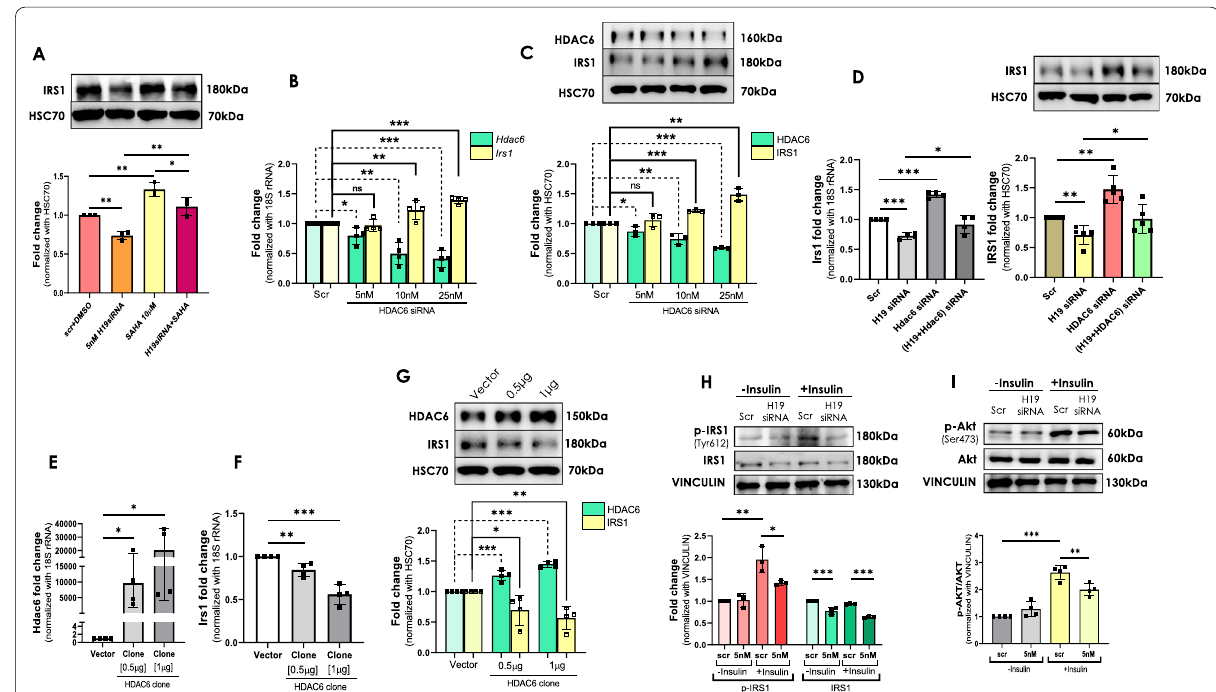
Fig. 5 H19 inhibition regulates IRS1 levels in HDAC6 dependent manner and impairs insulin signaling in C2C12 cells. A Differentiated C2C12 cells were transfected with the scramble or H19 siRNA (5 nM) and treated with wither DMSO or the HDAC inhibitor, SAHA (10 µM). On termination of incubation (24 h), cells were lysed and 30 µg protein was resolved on SDS-PAGE and subjected to Western Blot analysis using anti-IRS1 antibody. HSC70 was used as the loading control. The blot presented is a representative blot and given below is the densitometric analysis of three independent experiments. B Differentiated C2C12 cells were transfected with either scramble or HDAC6 siRNA (5–25 nM) and after 48 h of transfection, cells were lysed and 1 μg of total RNA was reverse transcribed and the transcript levels of Hdac6 and Irs1 were detected by qRT-PCR. 18S rRNA was taken as the endogenous control. C Differentiated C2C12 cells were transfected as in “B” and after 48 h of transfection, 20 µg of protein was resolved on SDS-PAGE and probed using anti-HDAC6 and anti-IRS1 antibodies. HSC70 was used as the loading control. The blot presented is a representative figure and given below is the densitometric analysis of three independent experiments. D Differentiated C2C12 cells were transfected with the scramble or H19 siRNA (5 nM) alone or together with HDAC6 siRNA (25 nM). After 48 h of transfection, cells were lysed and 1 μg of total RNA was reverse transcribed and the transcript levels of Irs1 were determined by qRT-PCR. 18S rRNA was taken as the endogenous control. Also, after a similar transfection, 20 µg of protein from scramble or H19 siRNA alone or together with HDAC6 siRNA transfected cells was resolved on SDS-PAGE and probed using anti-IRS1 antibody. HSC70 was used as the loading control. The blot presented is a representative figure and given below is the densitometric analysis of at least five independent experiments. C2C12 cells were transfected with either control vector or HDAC6 cloned vector (0.5 µg and 1 μg) and 48 h post-transfection, cells were lysed and the transcript levels of Hdac6 ( E ) or Irs1 ( F ) were determined by qRT-PCR. 18S rRNA was used as the endogenous control. G Differentiated C2C12 cells were transfected with either control vector or HDAC6 overexpression vector (0.5 µg and 1 μg) and 48 h post-transfection, cells were lysed and 20 µg lysate was resolved on SDS-PAGE and probed using anti-HDAC6 and anti-IRS1 antibody. HSC70 was used as the loading control. The blot presented is a representative figure and given below is the densitometric analysis of four independent biological replicates. Differentiated C2C12 cells were transfected with either the scramble or H19 siRNAs and after 48 h of transfection, cells were treated with insulin (100 nM, 20 min). On termination of incubation, cells were lysed and probed for IRS1, pIRS1 ( H ) and Akt, pAkt ( I ) protein levels by Western Blot analysis using specific antibodies. Vinculin was taken as the loading control. All experiments were done at least thrice and densitometric analyses of the same are provided. Values are